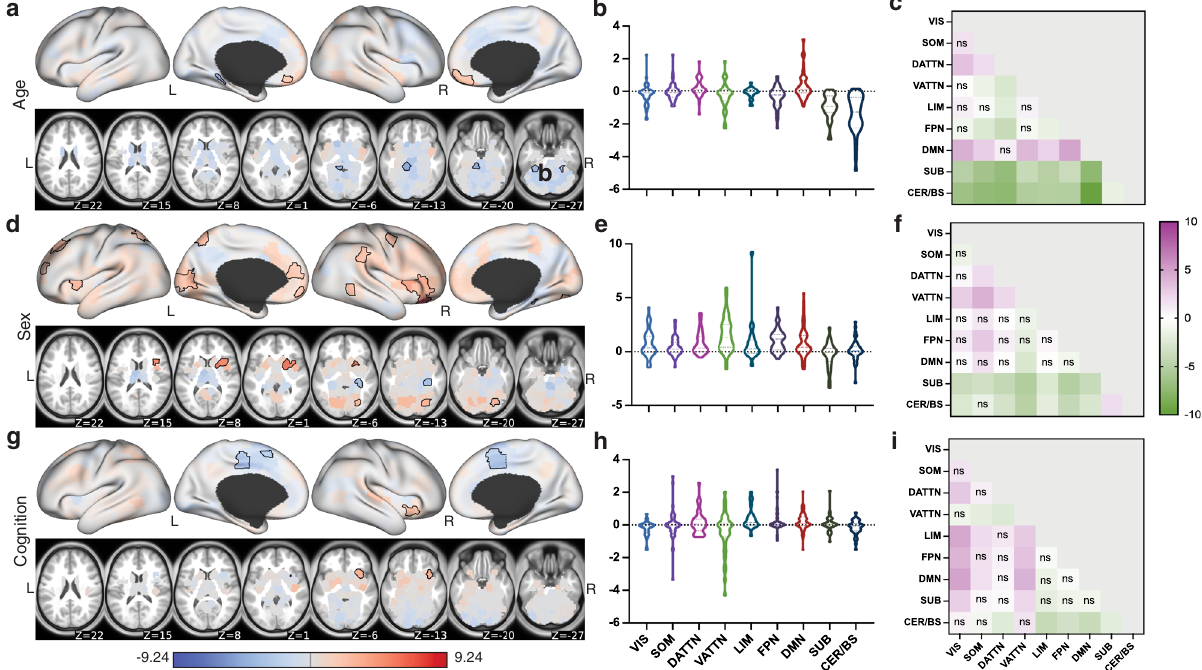
Fig. 4 Associations between regional SC – FC coupling and age, sex, and total cognition. a , d , and g display regional β -values from the GLM quantifying associations between SC – FC coupling and age, sex (blue indicates higher SC – FC coupling in females, red higher in males) and total cognition scores, respectively. Areas with signi fi cant β -values (after correction) are outlined in black. b , e , and h show the network-wise β -values for age, sex and total cognition, respectively. c , f , and i show the t -statistics for all pairwise comparisons of the associations across networks, calculated as the network on the y - axis versus the network on the x -axis. One-sided p -values were calculated (see detailed description in the “ Methods ” section). Those comparisons with FDR corrected p > 0.05 are marked with ns